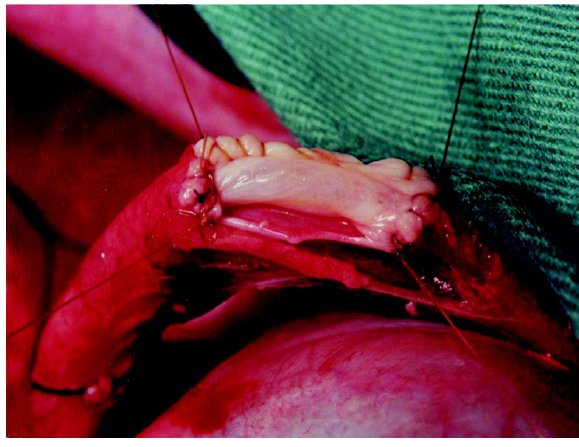
Figure 1 – Small intestine submucosa graft sutured in the cut edges of the right